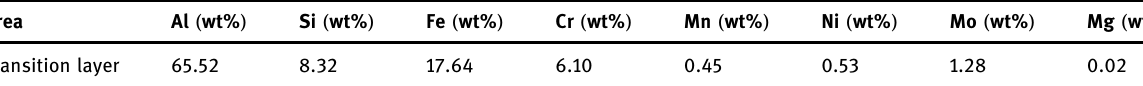
Table 3: The EDS results of transition layer